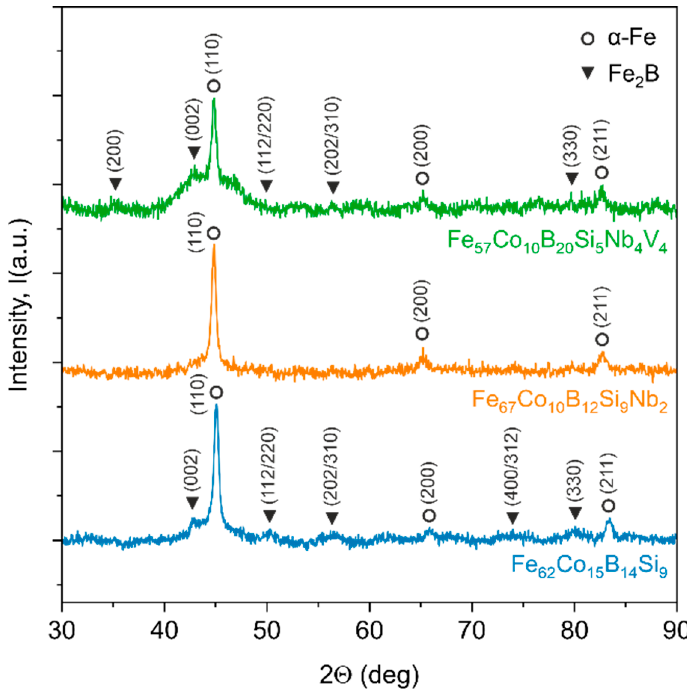
Figure 4. XRD patterns for as ‐ quenched samples.